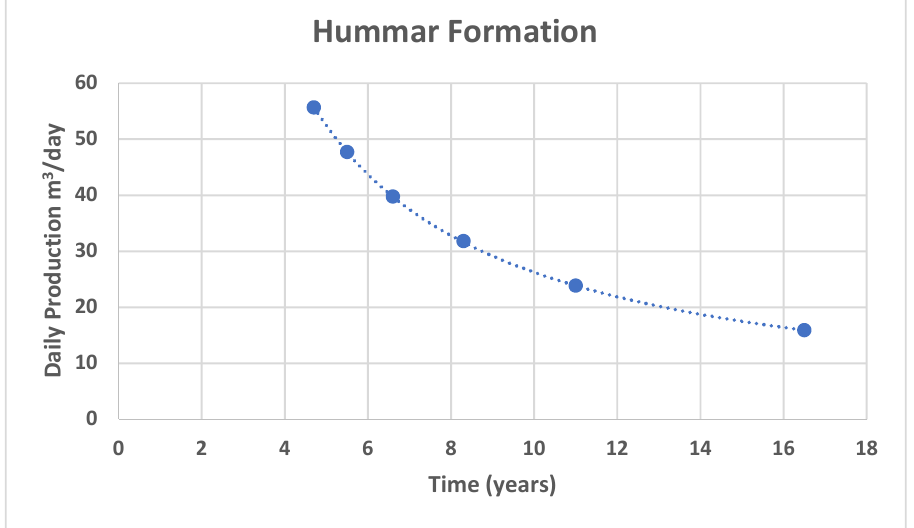
Figure 18. Water breakthrough daily production for the Hummar formation.